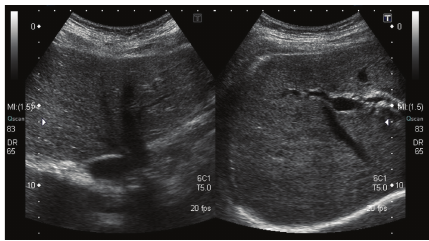
Figure 1: Abdominal ultrasonography (coarsening in liver parenchyma and minimally prominent intrahepatic bile ducts).